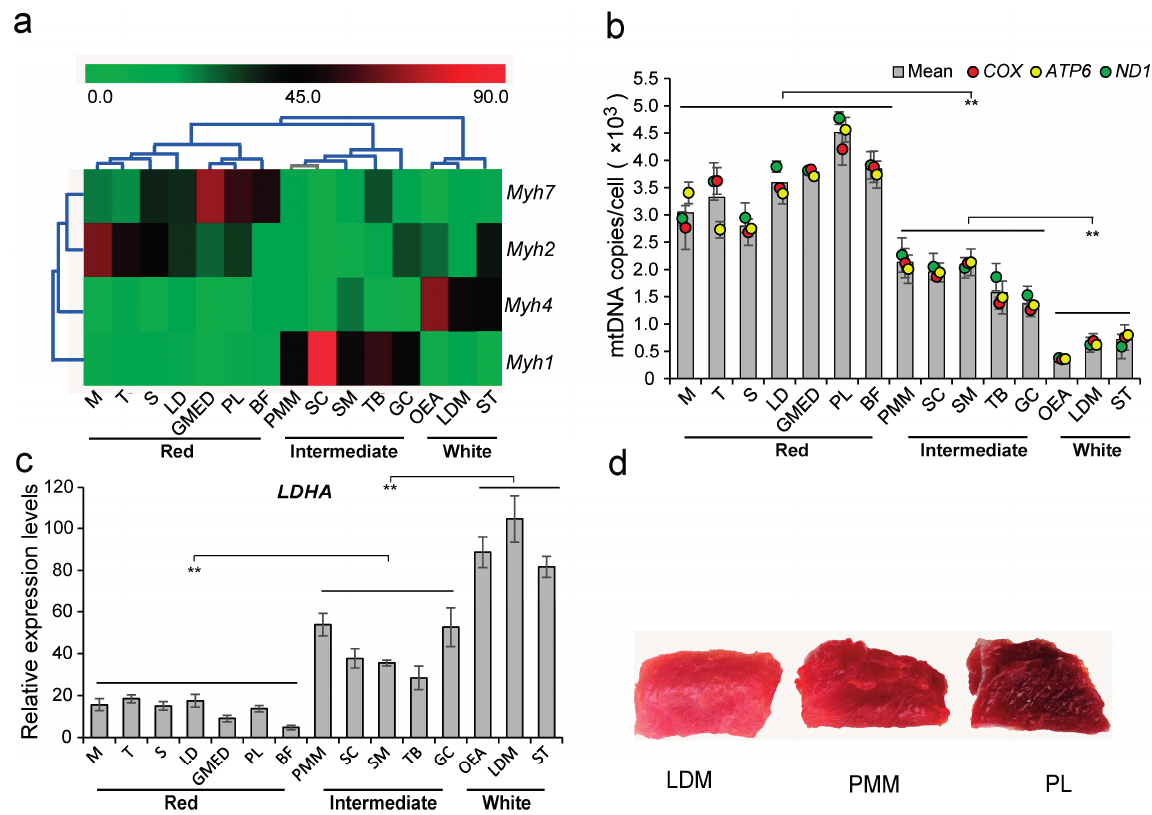
Figure 1. The characterization of various skeletal muscles. ( a ) Hierarchical clustering analysis for the ratios of myosin heavy chain isoforms in 15 muscle tissues based on Pearson correlation. M, masseter ; T, trapezius ; S, soleus ; LD, latissimus dorsi ; GMED, gluteus medius ; PL, peroneal longus ; BF, biceps femoris ; PMM, psoas major muscle; SC, semispinalis capitis ; SM, semimembranosus ; TB, triceps brachii ; GC, gastrocnemius ; OEA, obliquus externus abdominis ; LDM, longissimus dorsi muscle; ST, semitendinosus ; ( b ) mtDNA copies per cell in 15 muscle tissues ( p < 0.01); ( c ) The relative expression of lactose dehydrogenase A ( LDHA ) in 15 muscle tissues ( p < 0.01); ( d ) The colors of